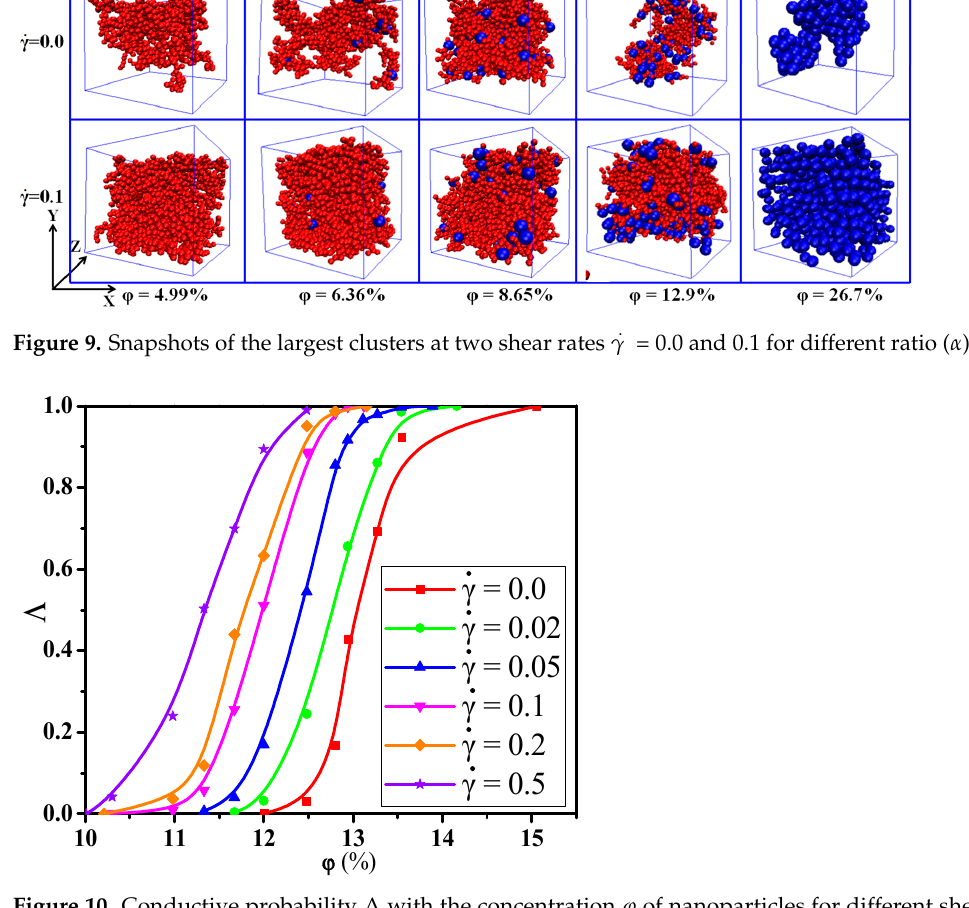
Figure 10. Conductive probability Λ with the concentration ϕ of nanoparticles for different shear rates ( γ ).